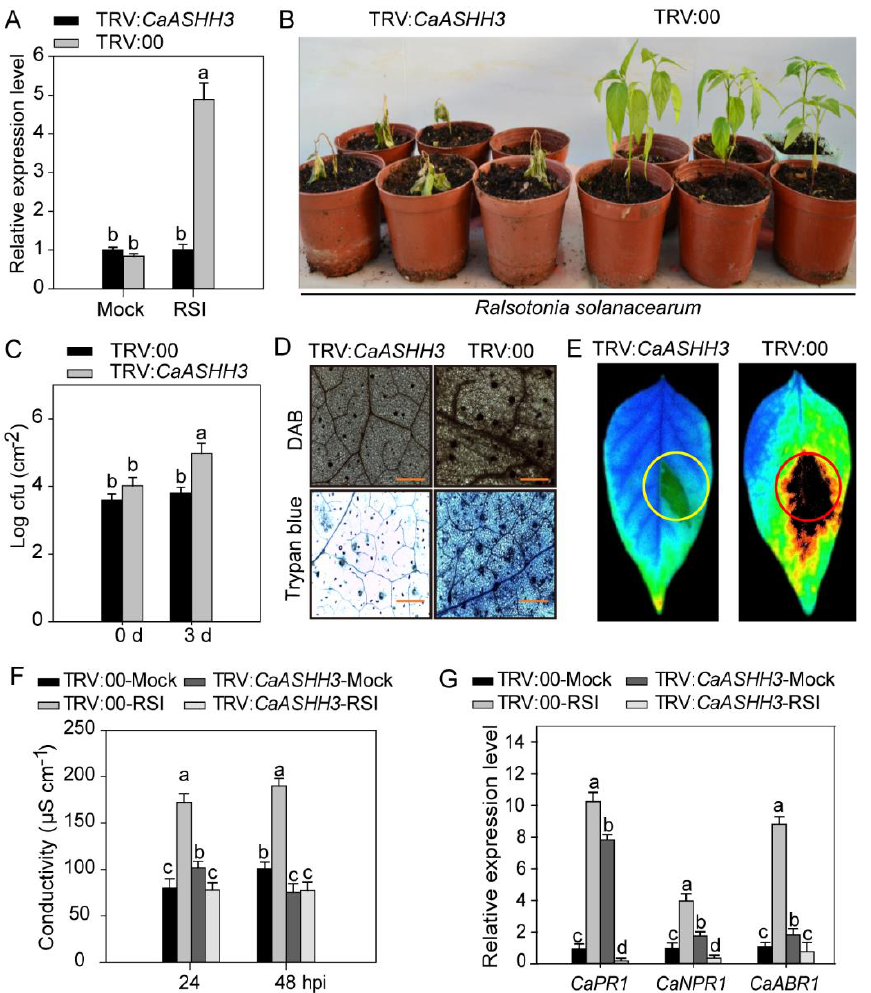
Figure 4. The CaASHH3 silencing impaired the pepper plants’ resistance to Ralstonia solanacearum inoculation. ( A ) Real-time qRT-PCR analysis of CaASHH3 transcript accumulation in CaASHH3 -silenced (TRV: CaASHH3 ) and unsilenced plants (TRV:00) inoculated with R. solanacearum . ( B ) Phenotypic effect of R. solanacearum treatment on CaASHH3 -silenced and unsilenced plants at 7 dpi. ( C ) Comparison of growth of R. solanacearum in CaASHH3 -silenced and unsilenced plants inoculated with R. solanacearum at 0 and 3 dpi. ( D ) DAB and trypan blue staining in R. solanacearum -infected CaASHH3 -silenced and unsilenced leaves at 2 dpi. Scale bar = 50 µm. ( E ) Assessment of cell death in R. solanacearum -infected, CaASHH3 -silenced and unsilenced leaves under fluorescent modulation meter. ( F ) Measurement of electrolyte leakage as ion conductivity to check the cell death responses in leaf discs of CaASHH3 -silenced and unsilenced plants at 24 and 48 hpi and without inoculation of R. solanacearum . ( G ) qRT-PCR expression of transcript levels of defense-associated marker genes in CaASHH3 -silenced and unsilenced plants after inoculation and without inoculation of R. solanacearum at 24 hpi, respectively. The relative transcriptional expression levels of CaASHH3 in mock-treated unsilenced plants were normalized to 1. Error bars indicate the standard error. Data represent the means ± SE from four biological replicates. Different letters indicate significant differences between means, as determined by Fisher’s protected LSD test: lowercase letters represent p < 0.05.